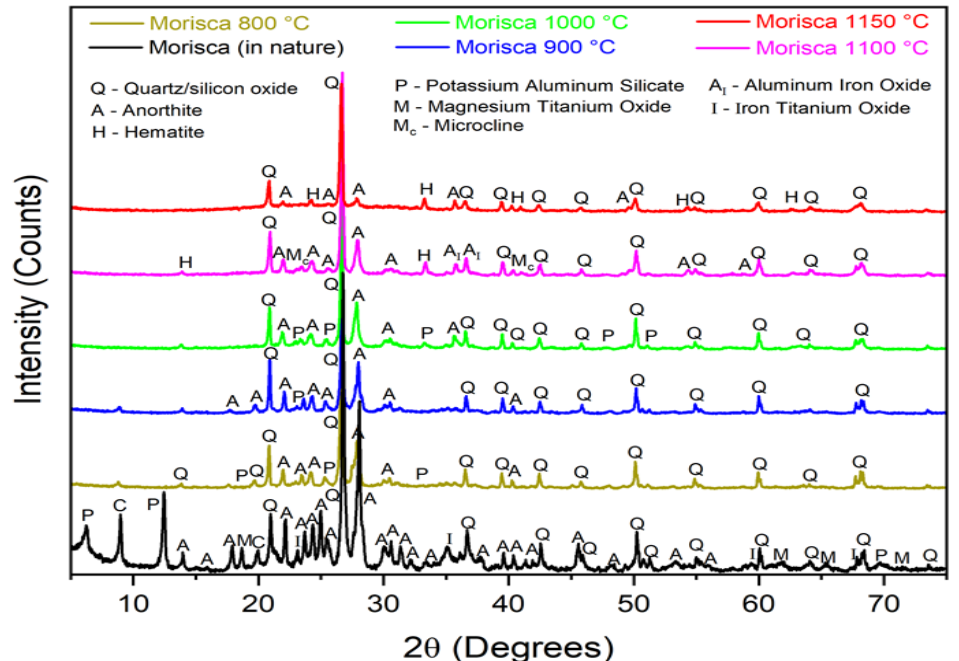
Figure 8. XRD comparison diffractogram of morisca in nature with calcinations at 800 ◦ C, 900 ◦ C, 1000 ◦ C, 1100 ◦ C, and 1150 ◦ C. Step size of 2 ◦ min − 1 .